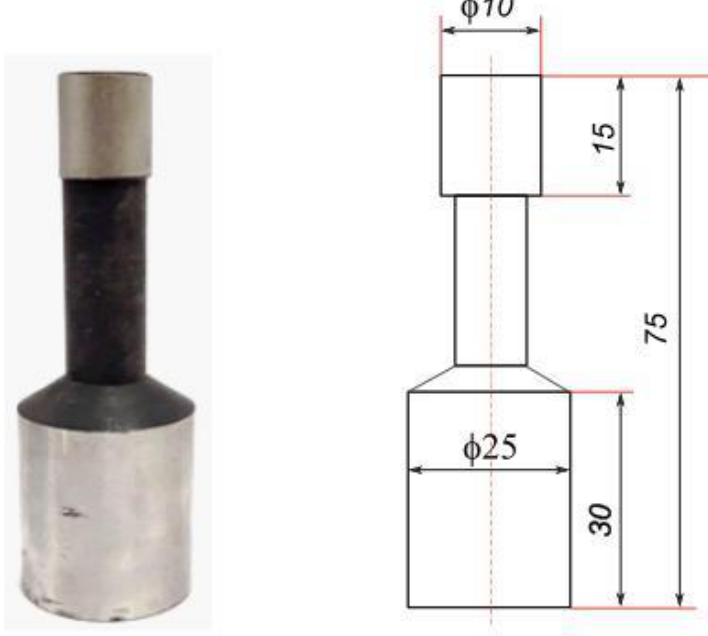
Table 3. Each experimental run was repeated three times to lessen the experimental error.